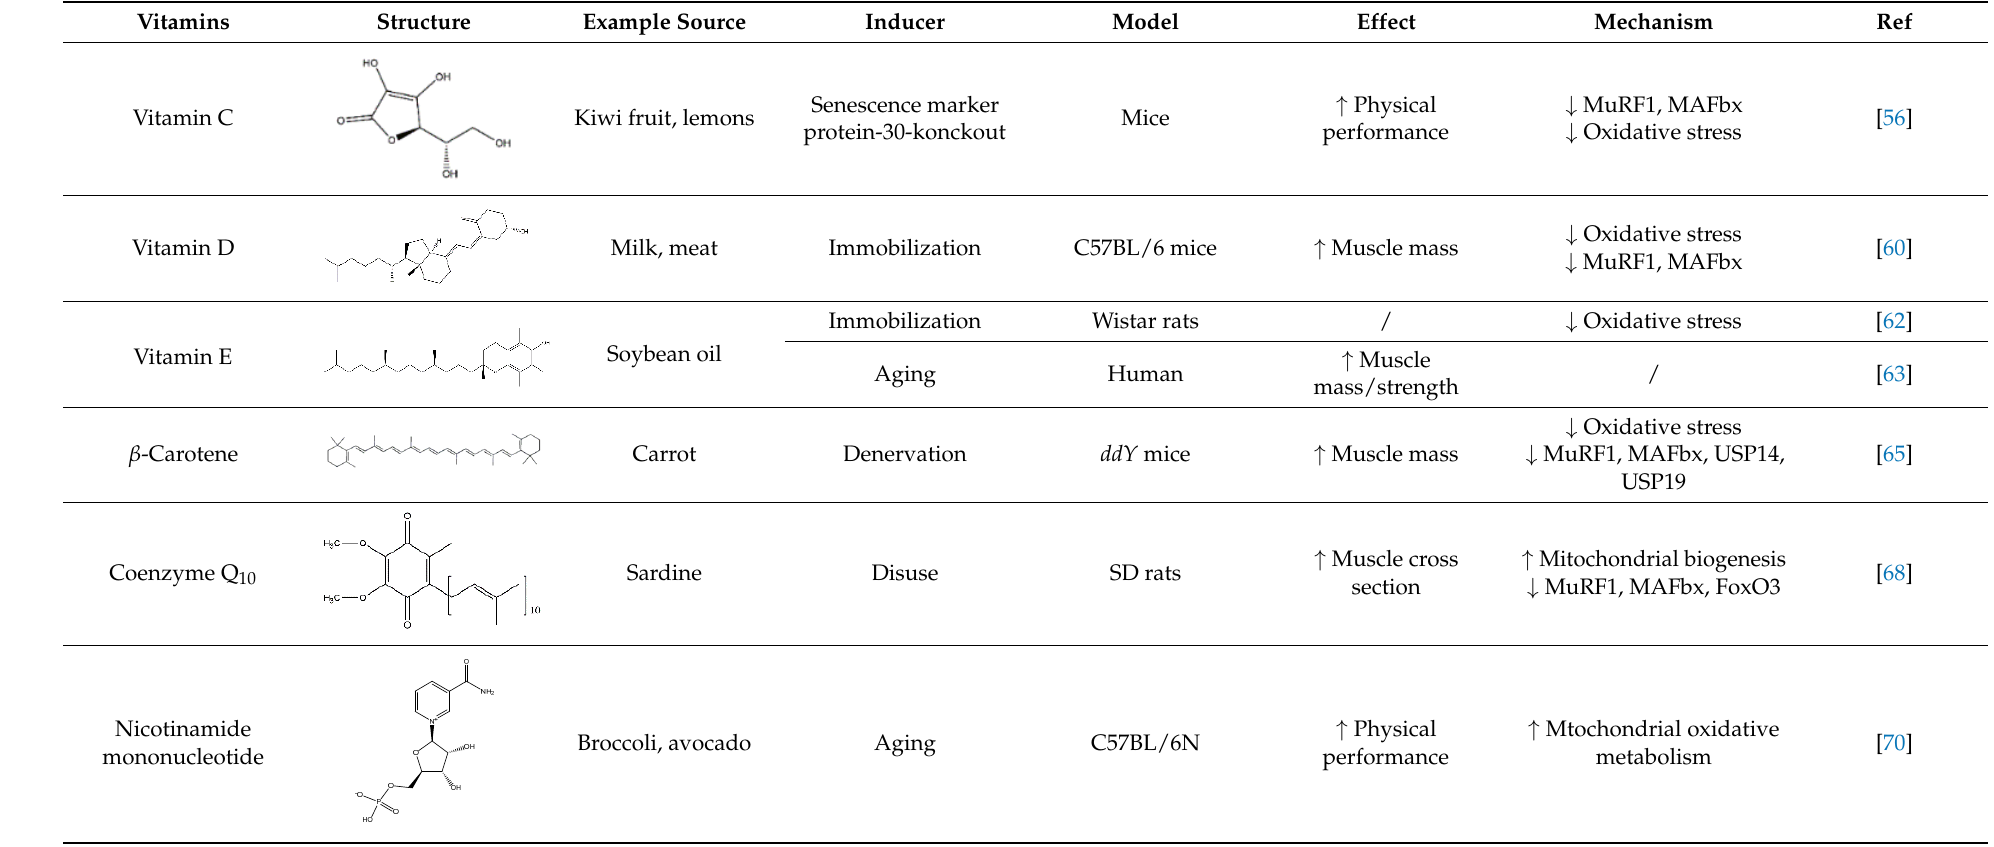
Table 3. Vitamins in the prevention of the muscle atrophy in vitro/vivo.